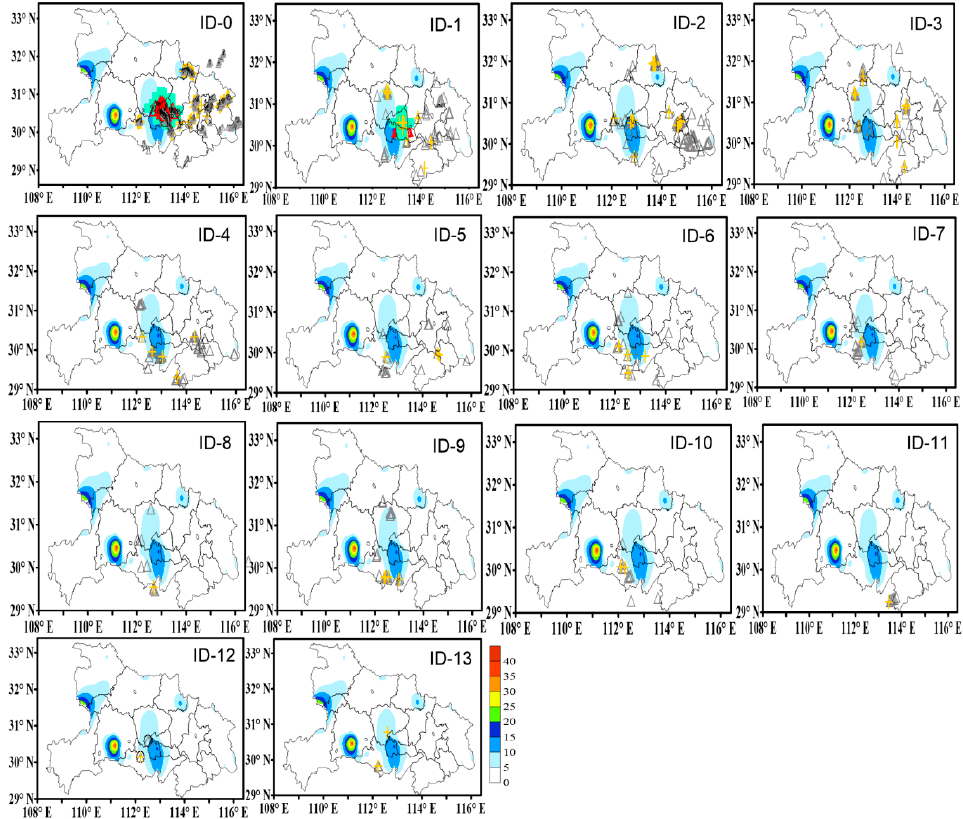
Figure 4. The spatial distribution of CG flashes produced by 14 thunderstorm cells and hourly precipitation (color contours, unit: mm) in Case 1 (grey triangle: 1 ≤ N -CG ≤ 100; red triangle: 100 < N -CG ; yellow plus: 1 ≤ N +CG ≤ 10; green plus: N +CG > 10, unit: flashes per 6 min).